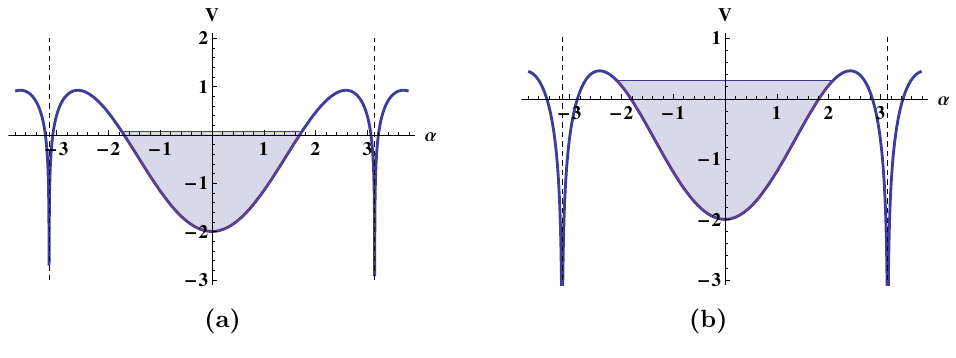
Figure 4 . Potential. (a) (cid:28) = (cid:0) 0 : 3 ; (cid:21) = 1, corresponding to region II. (b) (cid:28) = (cid:0) 0 : 5 ; (cid:21) = 1, (cid:11) 0 = 2 (cid:25)= 3, corresponding to the critical line separating region II and region III.